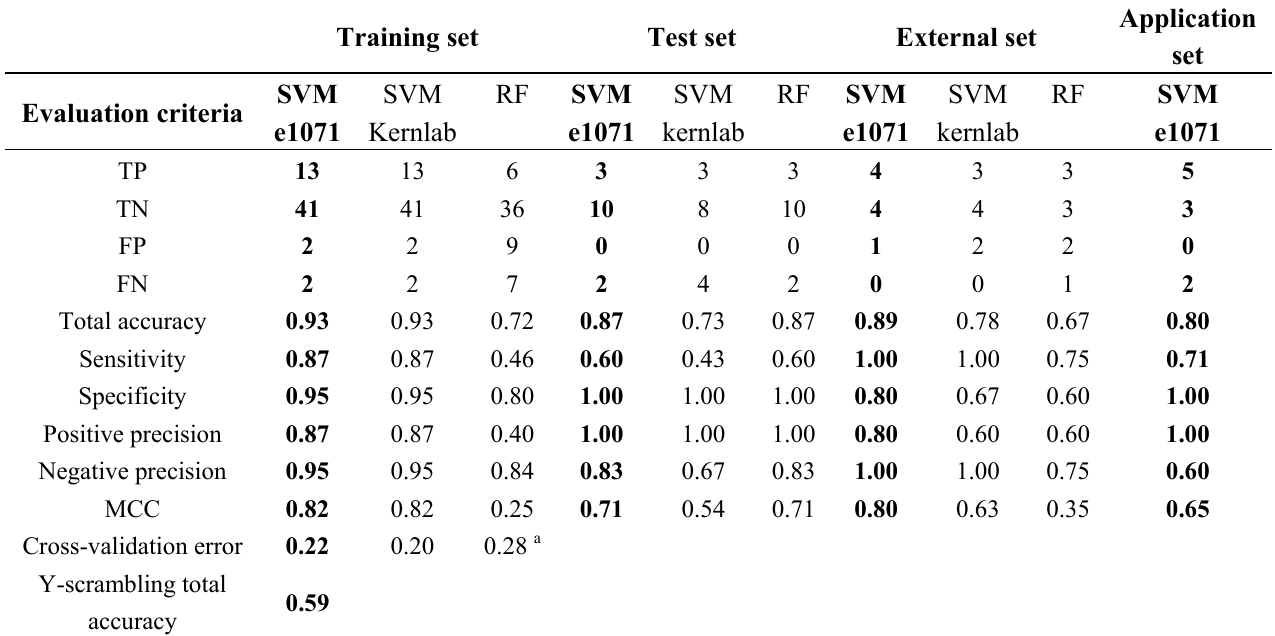
Table 4. Classification results from three classified